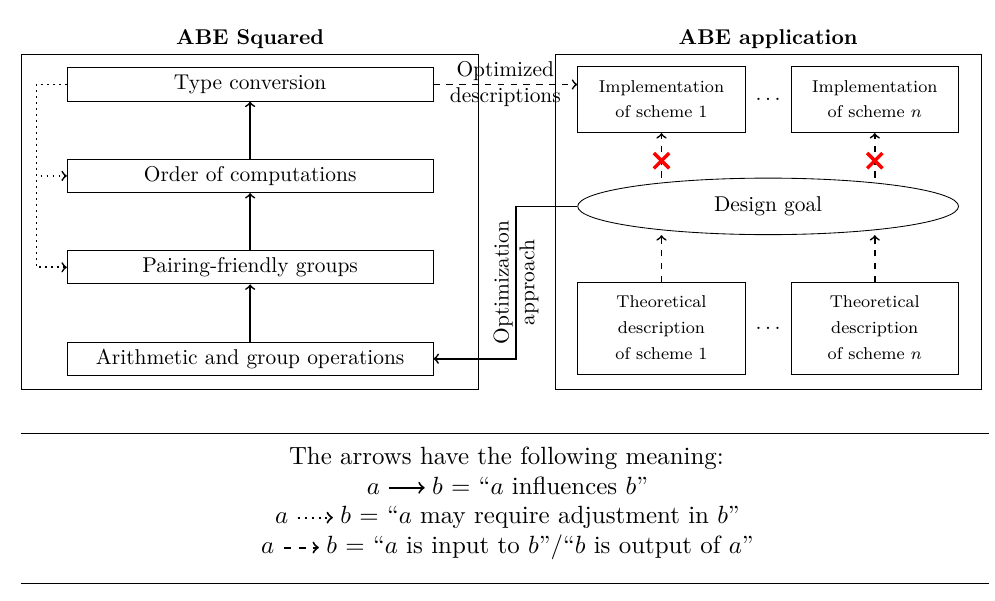
Figure 2: Overview of the ABE Squared framework and its relationship with ABE applications. In particular, the diagram describes the steps needed between the theoretical descriptions and the implementations of (possibly multiple) ABE schemes. Instead of moving from a design goal to the implementation of a scheme directly, we first optimize the theoretical description of the scheme for the chosen design